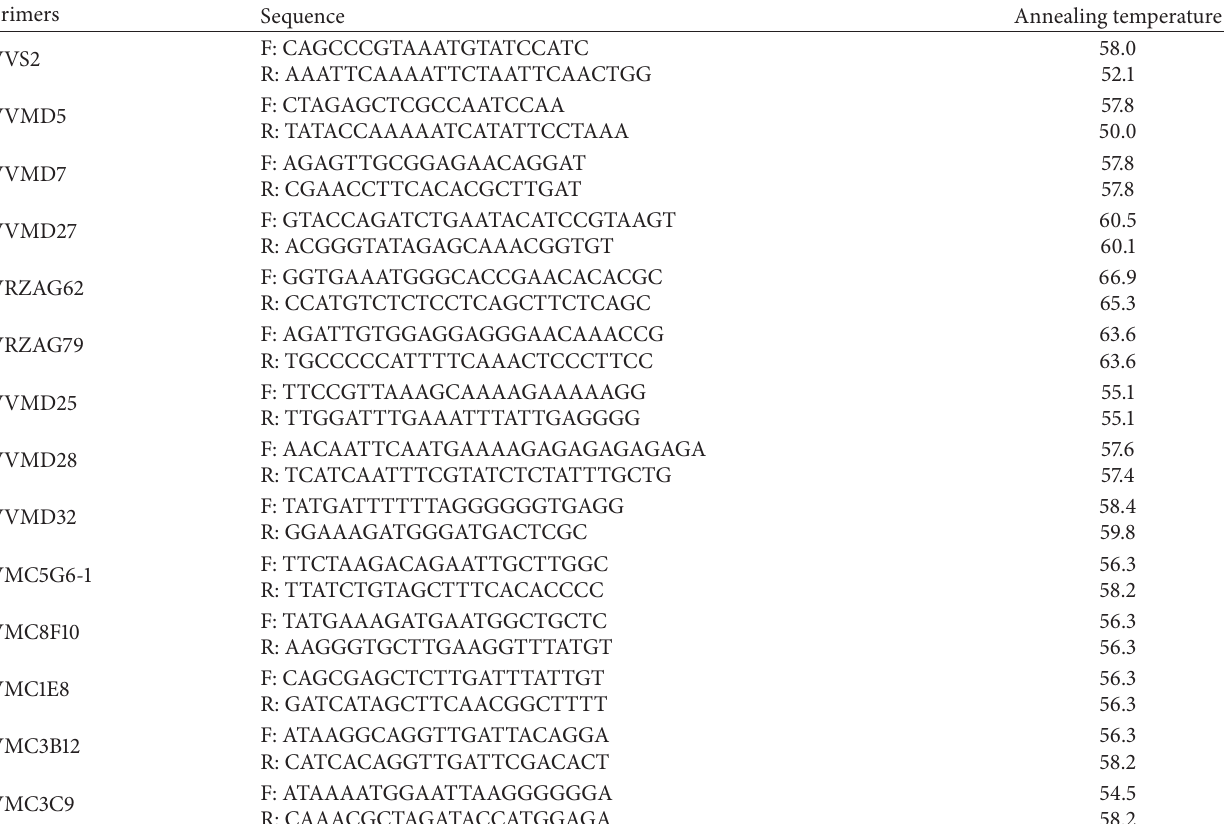
Table 1: 14 SSR primer sequences used in this